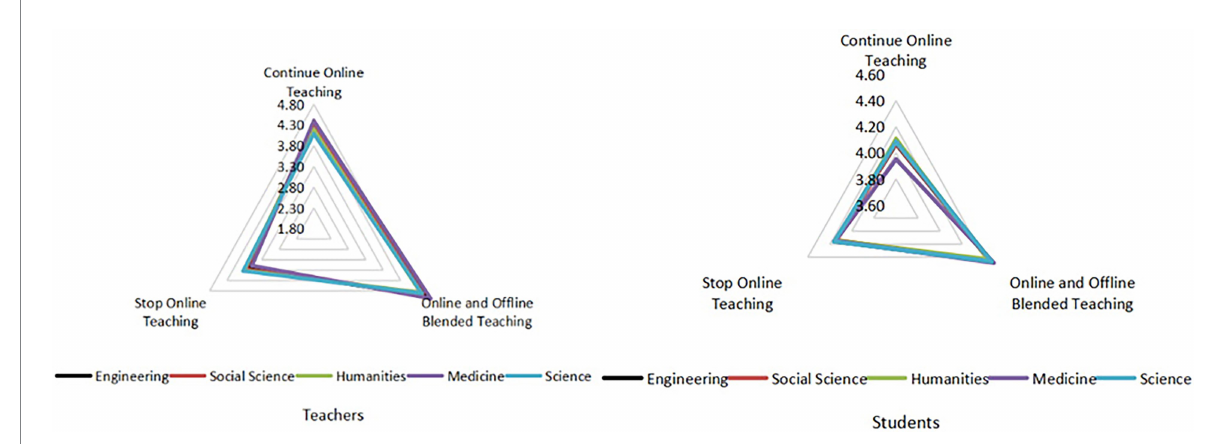
FIGURE 10 Views on the continuation of online education from teachers and students of different